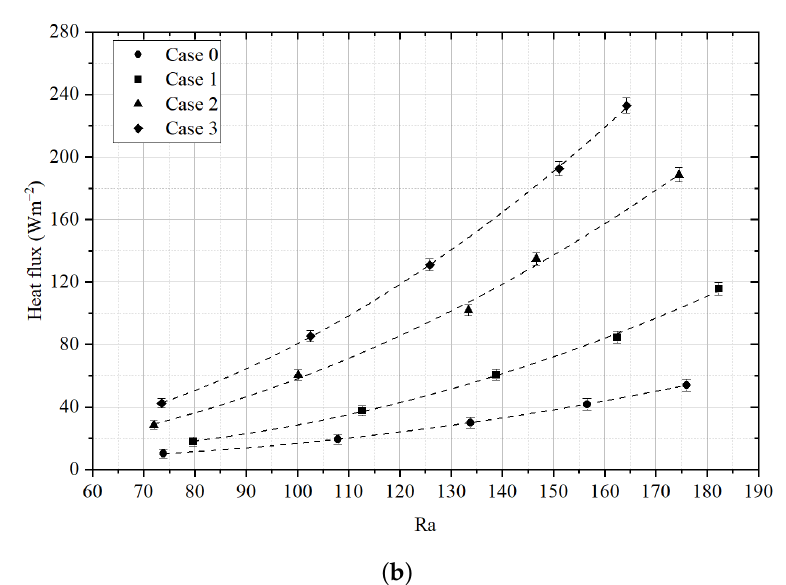
Figure 5. Heat-flux density as a function of the average Rayleigh numbers for four cases of the chimney height. ( a ) Heat exchanger no. 1. ( b ) Heat exchanger no.